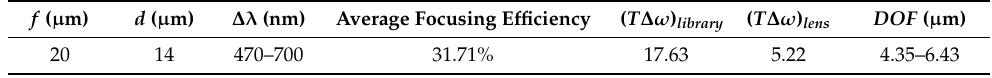
Table 2. Key parameters of the